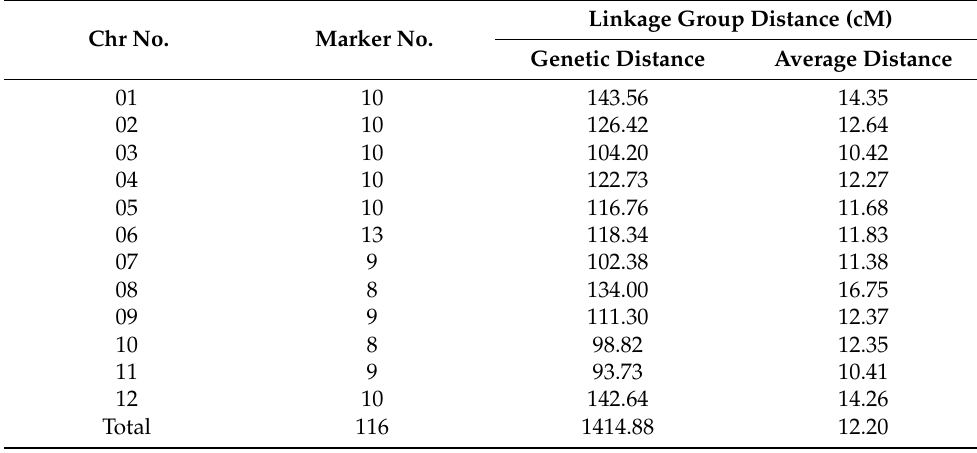
Table 4. Details of the genetic linkage map